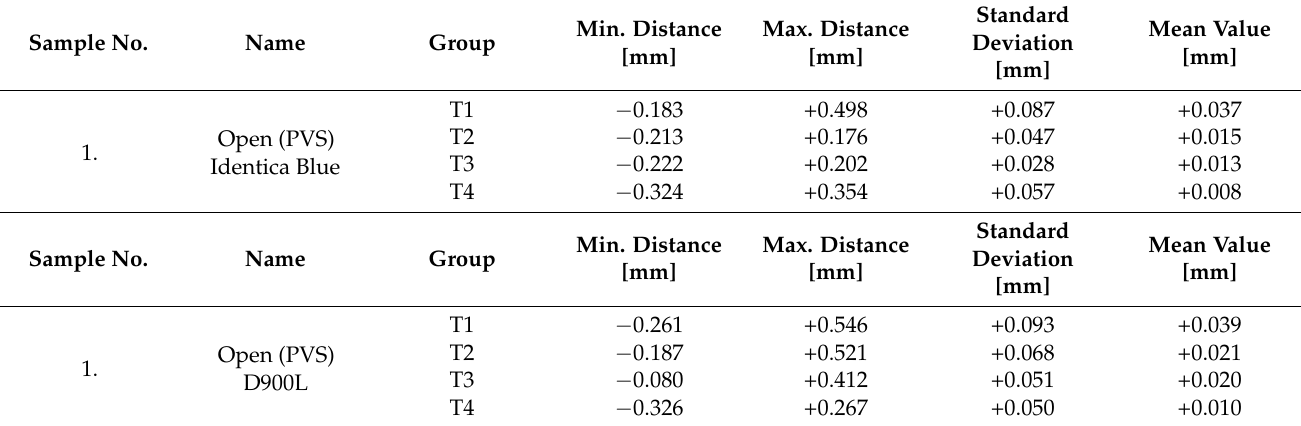
Table 2. CAD inspection results for all four teeth (T1–T4) based on open impression method using PVS material (sample no. 1) and both 3D scanners.